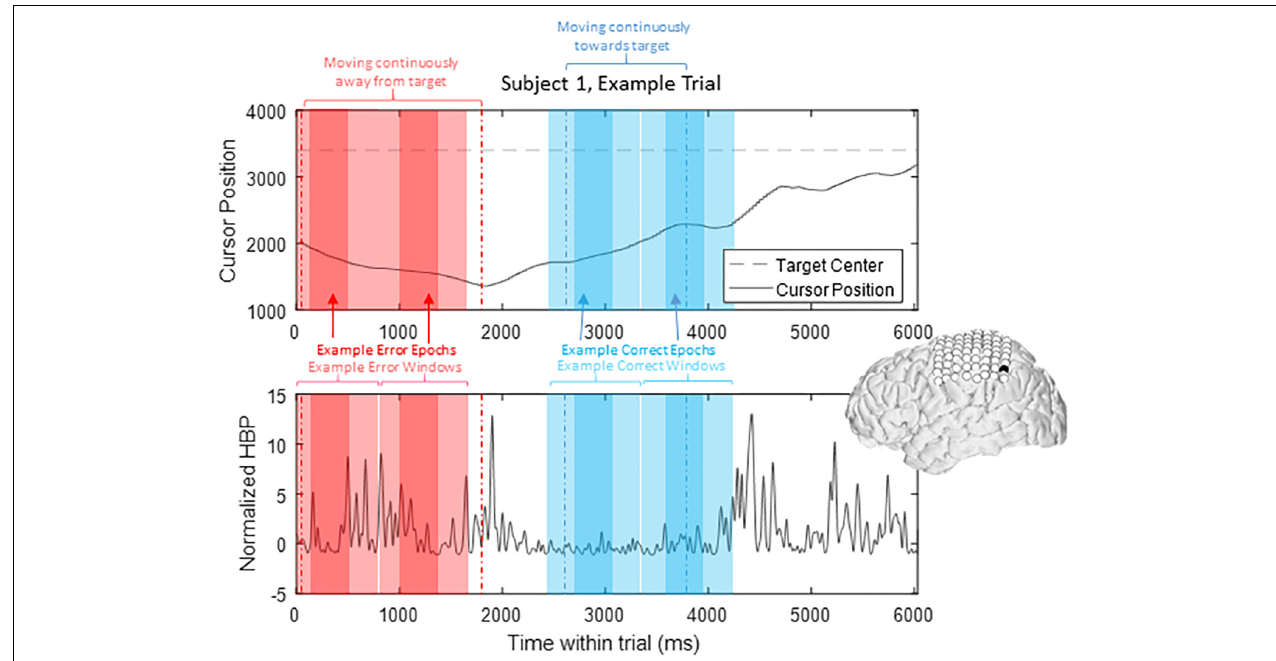
FIGURE 2 | HBP throughout one trial. In this parietal channel in one subject (shown in black), we see a decrease in HBP as the cursor moves correctly toward the target and increase when the cursor is no longer moving as intended. The highlighted light red sections shows example error windows, where their t = 0 time points are defined by 400 ms of continuous movement away from the target. The darker red areas represent example error epochs. Likewise, the highlighted light blue sections show example correct windows, and the dark blue sections show example correct epochs, as detailed in Section “Offline Analysis for Error-Related